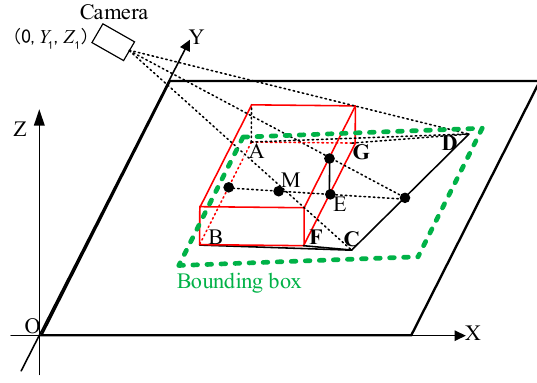
Figure 7. PTZ Camera imaging model in our method.